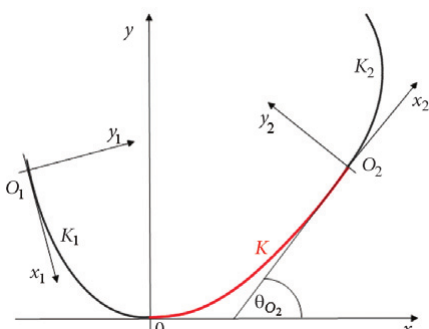
Fig. 1. Schema of the geometrical route